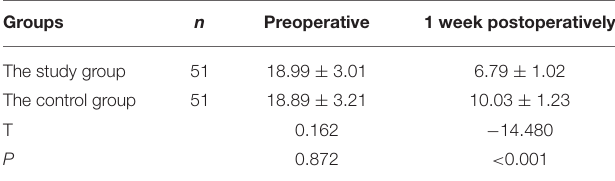
TABLE 2 | Comparison of recovery of neurological function in the two groups ( ¯ x ± s ).